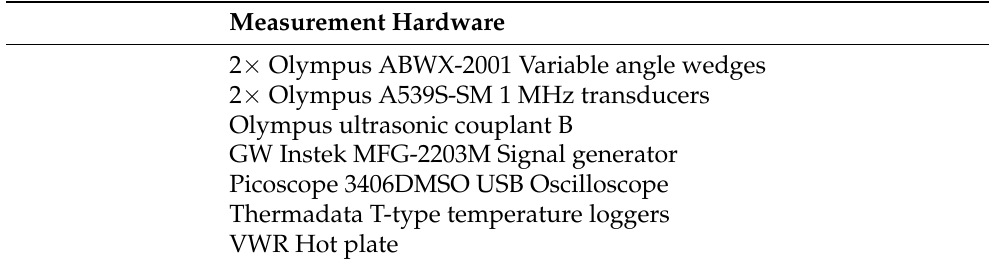
Table 2. Experimental measurement